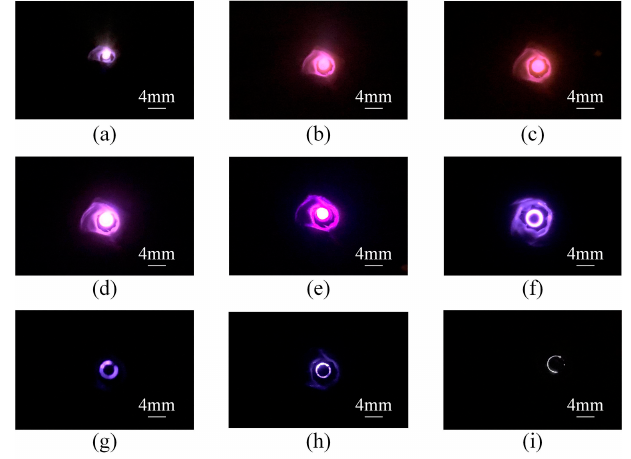
Figure 7. The images of ion source discharge at different pressures (mbar): ( a ) 6.3 × 10 − 4 ; ( b ) 7.4 × 10 − 3 ; ( c ) 1.6 × 10 − 2 ; ( d ) 4.6 × 10 − 1 ; ( e ) 7.4; ( f ) 1.4 × 10 1 ; ( g ) 1.2 × 10 2 ; ( h ) 5.4 × 10 2 ; ( i ) 1 × 10 3 .